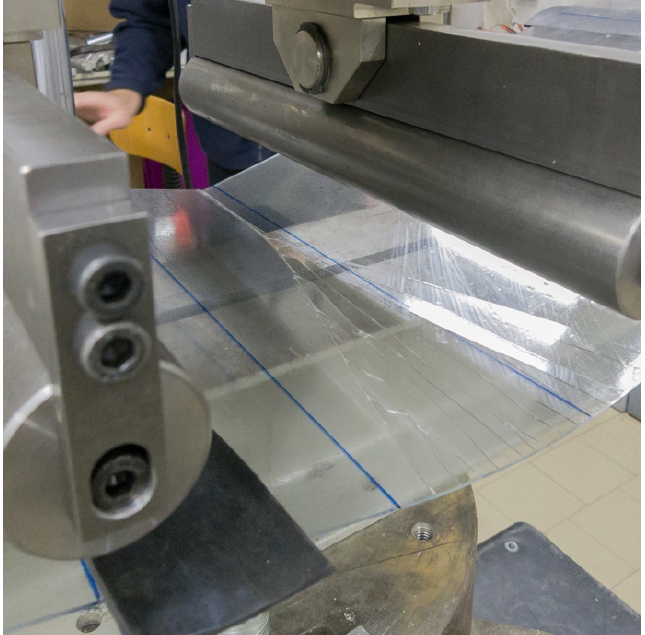
Fig. 3 Typical type of failure.